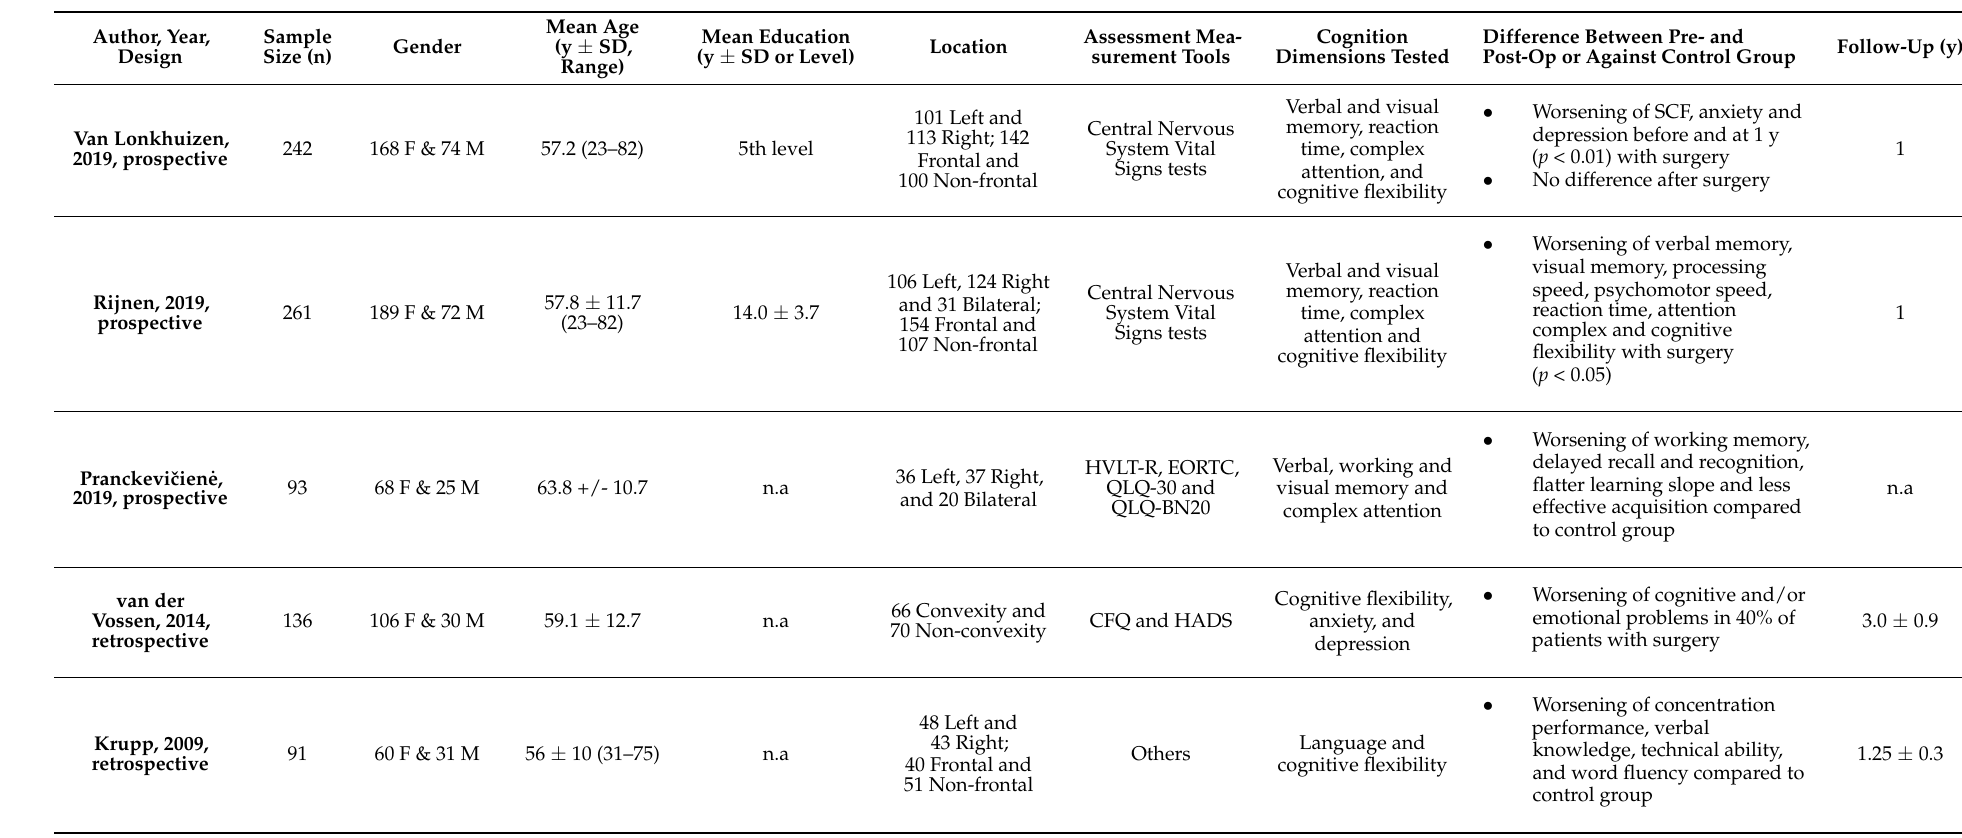
Table 2. Detailed description of the 5 biggest cohorts (study and patient characteristics). Controlled Oral Word Association Test (COWAT); female (F), male (M); not acknowledged